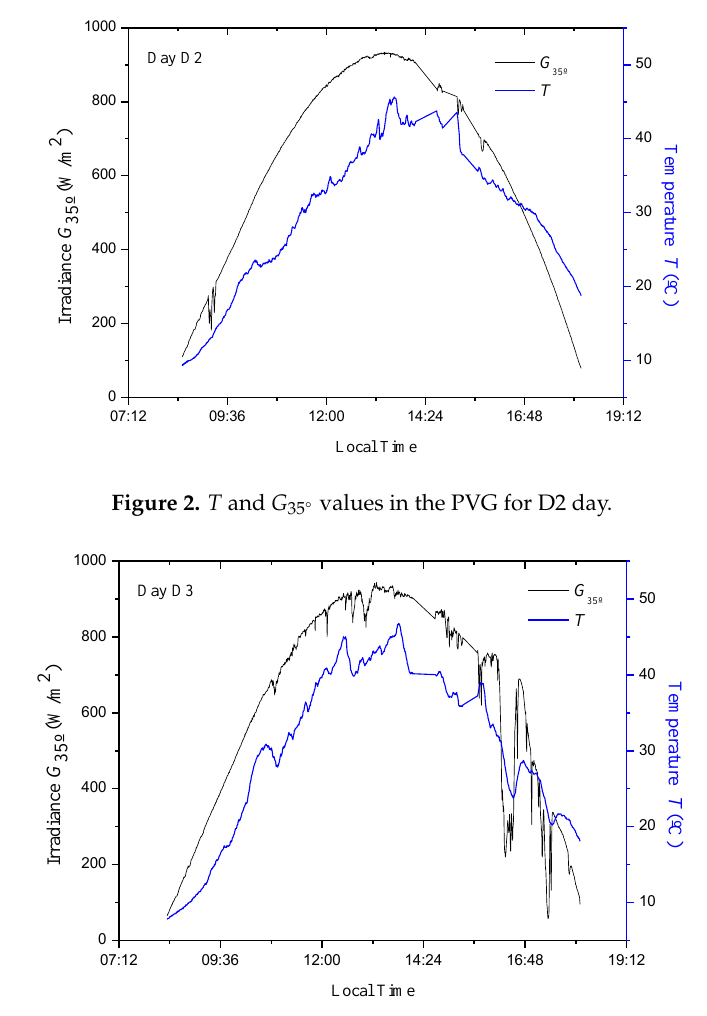
Figure 3. T and G 35° values in the PVG for D3 day. Table 1. Parameters of the photovoltaic module ISF-250.